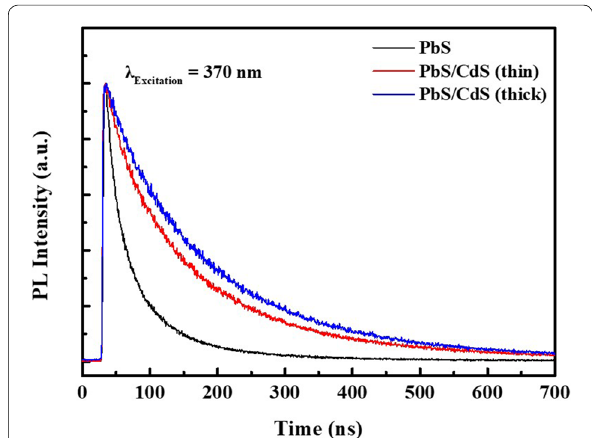
Fig. 3 Time‑resolved PL decay profiles of PbS, PbS/CdS (thin shell), and PbS/CdS (thick shell)